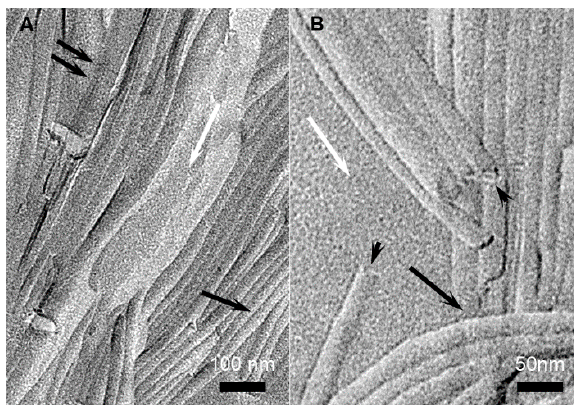
Figure 4. Freeze fractures of gels of HUB-3 in cyclohexane (2 wt.%). ( A ) large field view; ( B ) enlargement showing the ends of tubes. Black arrows: tubes; arrow heads: ends of tubes; white arrows: amorphous solvent; double arrow: lamellar aggregates.